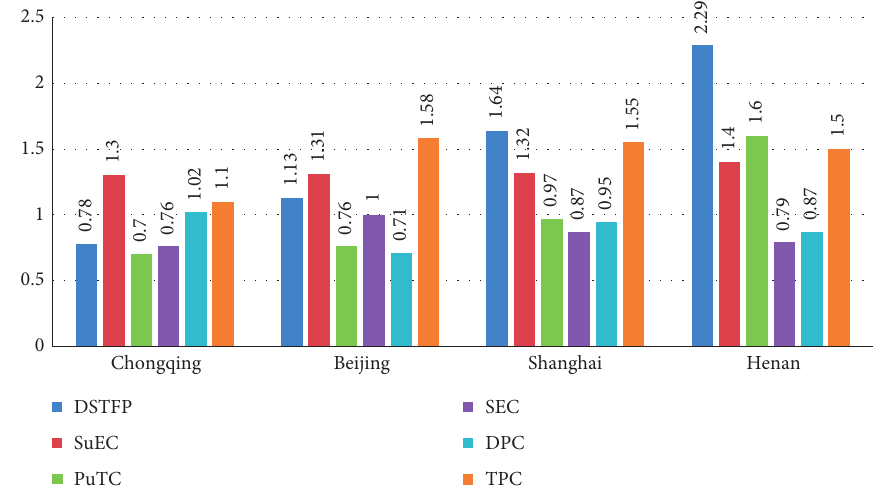
Figure 7: Decomposed efficiency indexes of SuECI.